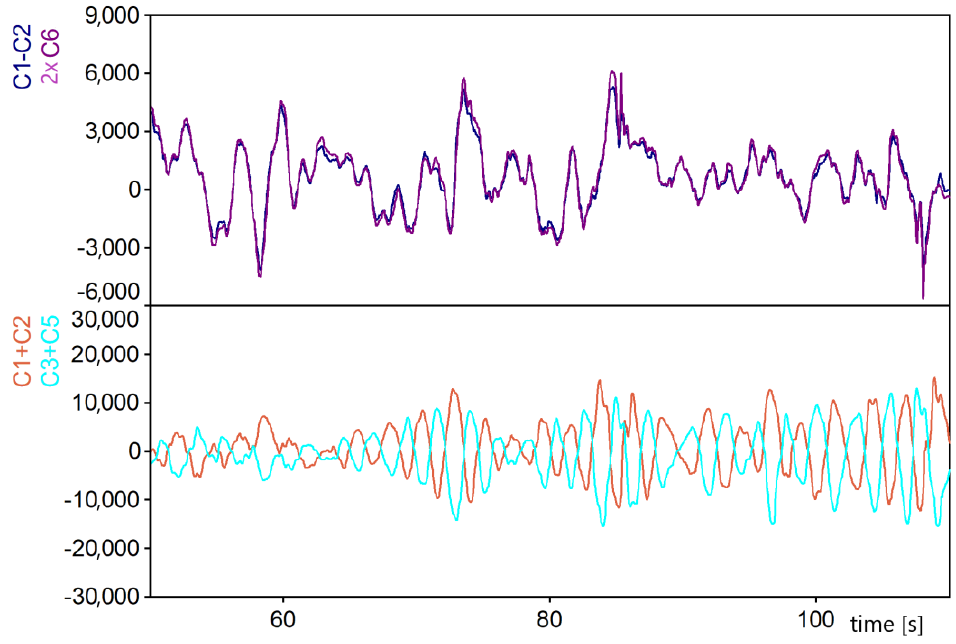
Figure 6. Value waveforms after conversion of selected measurement tracks.